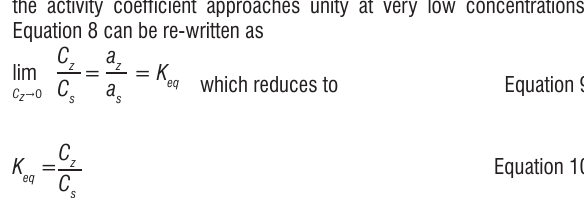
Values of various thermodynamic parameters for the adsorption of Ni (II) in solution onto natural and pretreated clinoptilolite